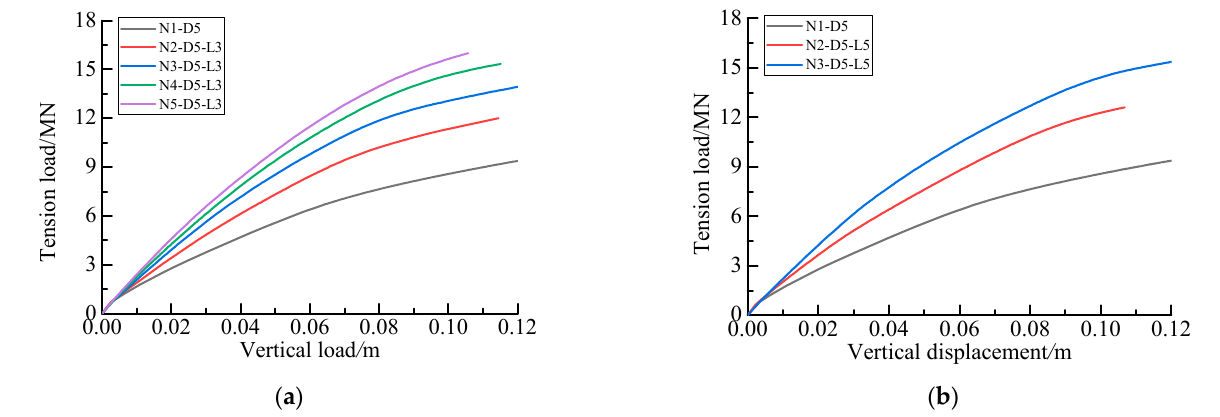
Figure 31. Uplift load-displacement curves of multi-blade helical pile. ( a ) D / d = 2, l/ D = 0.6, n = 1–5; ( b ) D / d = 2, l/ D = 1, n = 1–3. Table 11. Uplift efficiency coefficient of multi-blade helical pile. Condition Uplift Bearing Capacity